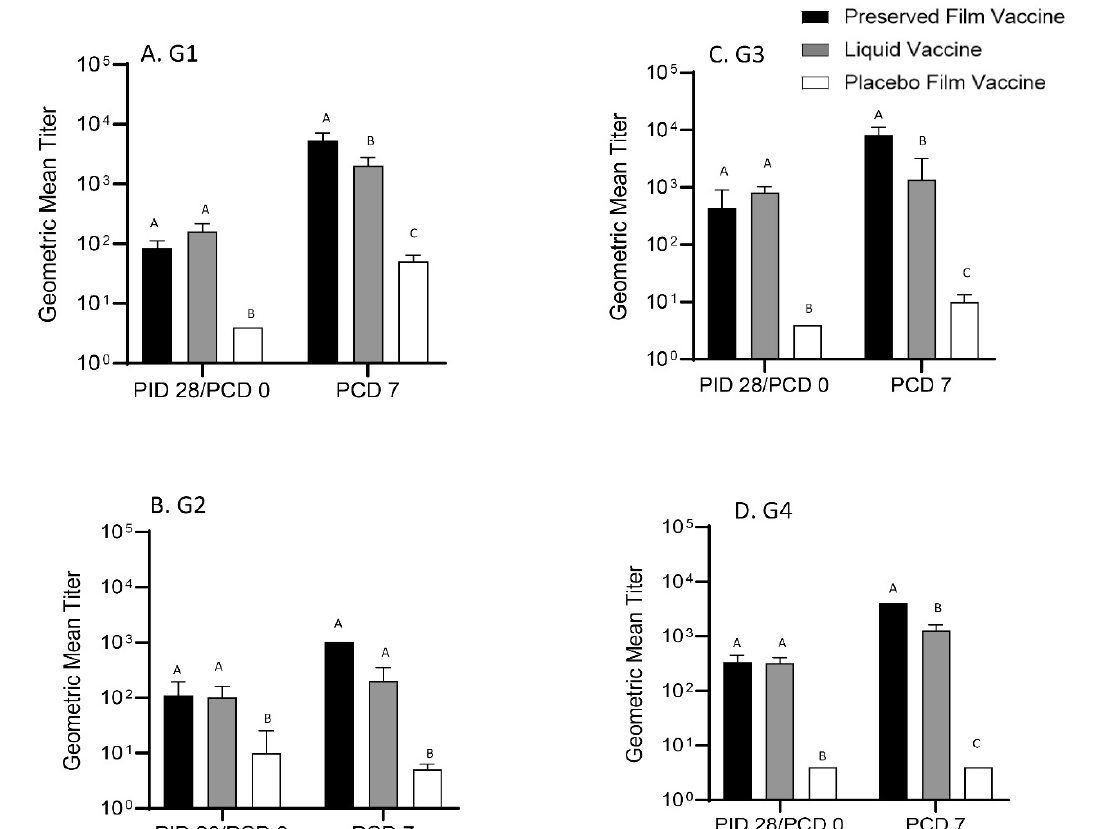
Figure 3. Geometric mean titers of virus-neutralizing (VN) antibodies in Gn pig serum samples at PID 28 and PCD 7. The sera were tested in a series of 4-fold dilutions, beginning at 1:4 in EMEM to 1:16384 for neutralization of 4 × 10 3 virions of G1 ( A ), G2 ( B ), G4 ( D ) human-rhesus reassortant rotaviruses and G3 ( C ) RRV. Different capital letters (A, B, C) on the top of the bars indicate a significant difference ( p < 0.05) between groups, while shared letters indicate no significant difference.